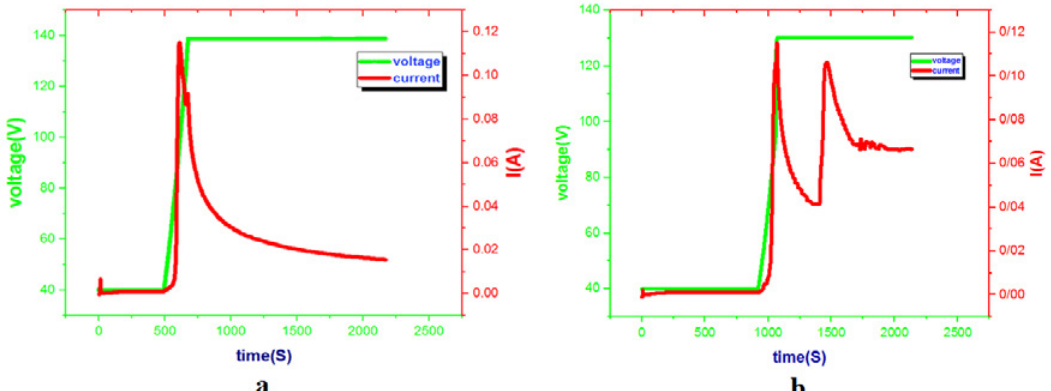
Fig. 1. Graph of voltage(V) and current(I) vs time(s) during anodization process (a)in oxalic acid (b) in mixture of oxalic acid and tin chloride